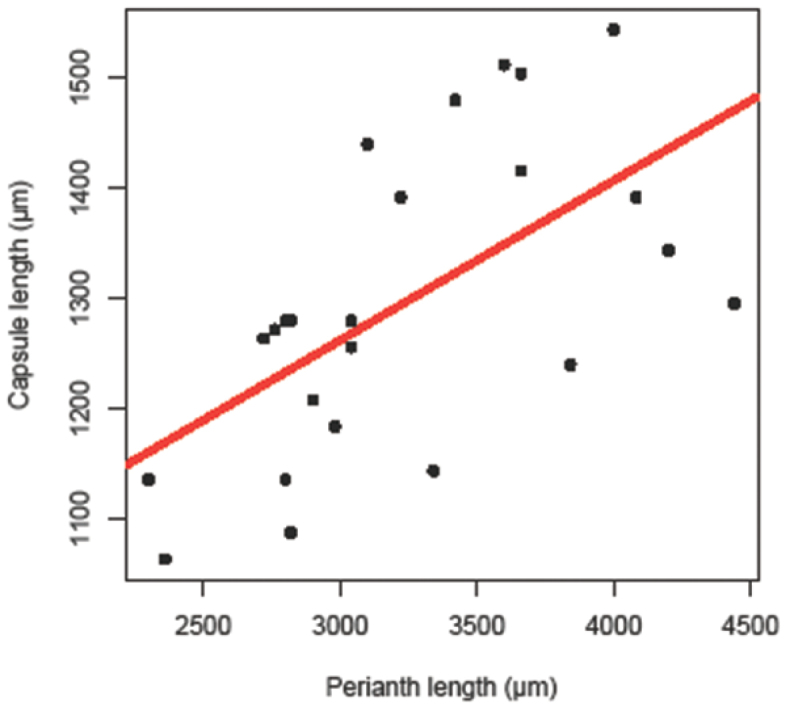
Scatterplot of perianth vs capsule valve length in three individuals of Radula strangulata from New Zealand. The red line shows the regression slope from the general linear model explaining the relationship between the two variables.